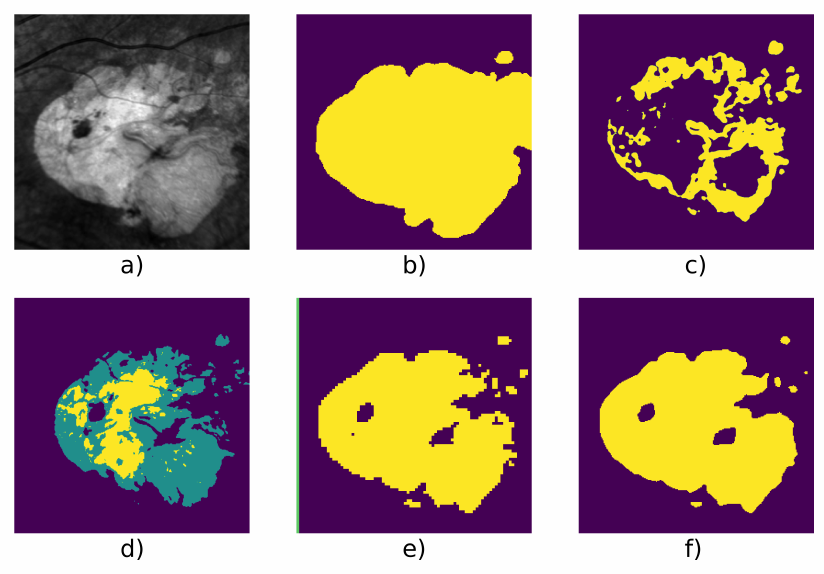
Figure 7. Patient id 016: ( a ) original image, ( b ) ground truth, ( c ) Gabor method segmentation,